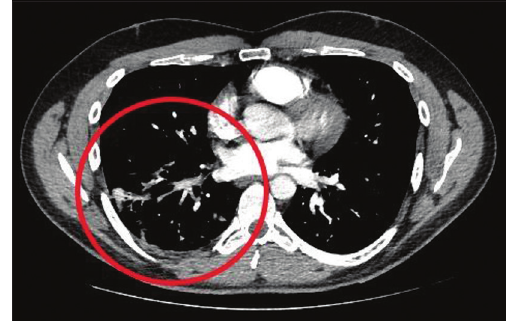
FIGURE 9. Chest CT angiography – January 7, 2021.